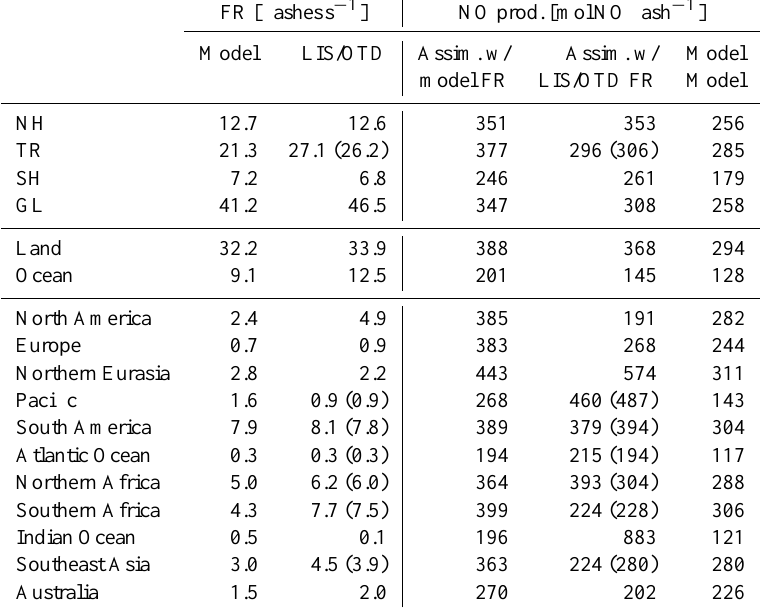
Table 7. The global and regional total flash rate (FR, flashess − 1 ) estimated from the model parameterization (1st row) and the LIS/OTD climatological observations (2nd row), and the NO production efficiency (NO prod., molNOflash − 1 ) estimated from the total LNO x sources analyzed from data assimilation with the model flash rate (3rd row) and with the LIS/OTD observations (4th row). The NO production efficiency predicted by the model, as estimated from the simulated LNO x sources and the model flash rate, is also shown (5th row). The definitions of the regions are same as for Fig. 7 and Table 1. The analysis results as measured from the LIS measurements for 2007 for regions within latitudes between 35 ◦ S and 35 ◦ N are shown in